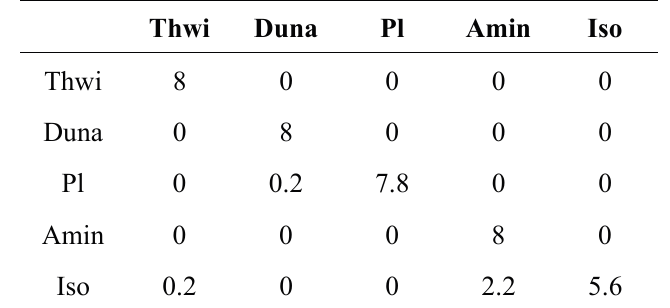
Table 9. Averaged confusion matrix obtained with the self-organizing maps (SOM) classification method when using the Savitzky-Golay and the Min-Max methods to denoise and normalize. Results of the confusion matrix have been averaged due to the five-fold